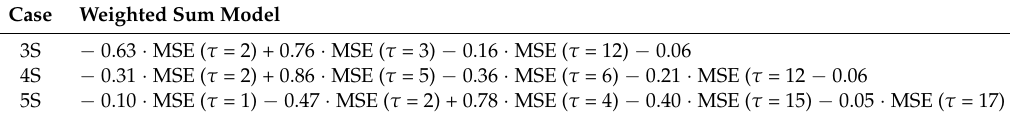
Table 6. The weighted sum models for the 3S–5S cases.